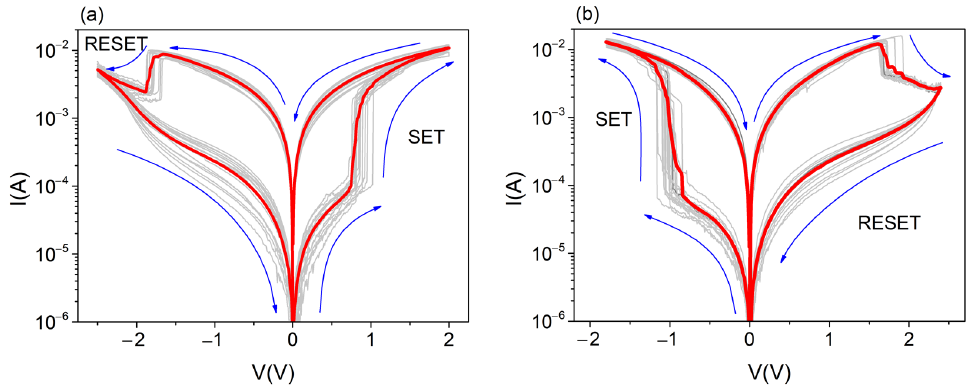
Figure 2. Current-Voltage curves of a TiN/Ti/HfO 2 /Pt sample with a HfO 2 thickness of ( a ) 8 nm and ( b ) 13 nm. The red curve represents an average of the 50 I-V loop shown in grey.